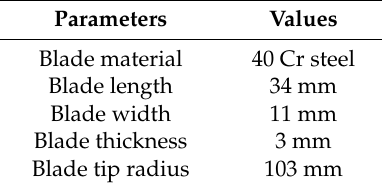
Table 1. Mechanical and geometrical properties of the blade used in the